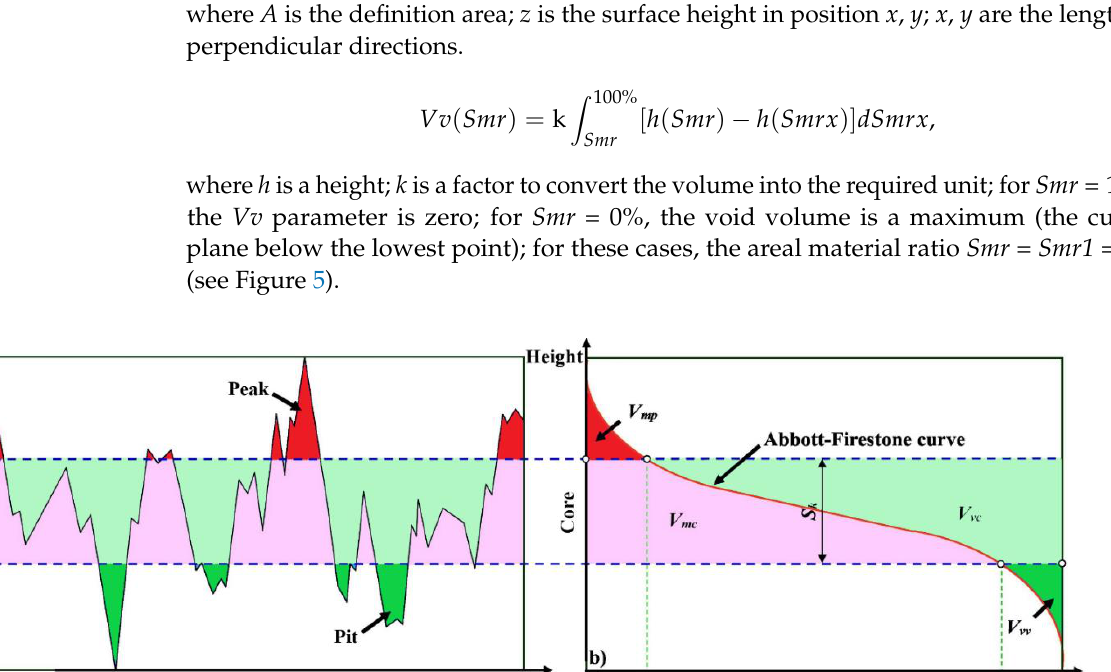
Table 1. Alicona G4 measurement device main parameters.